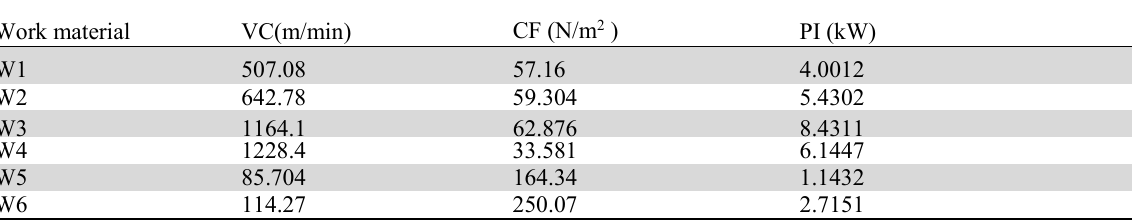
Weighted decision matrix of the